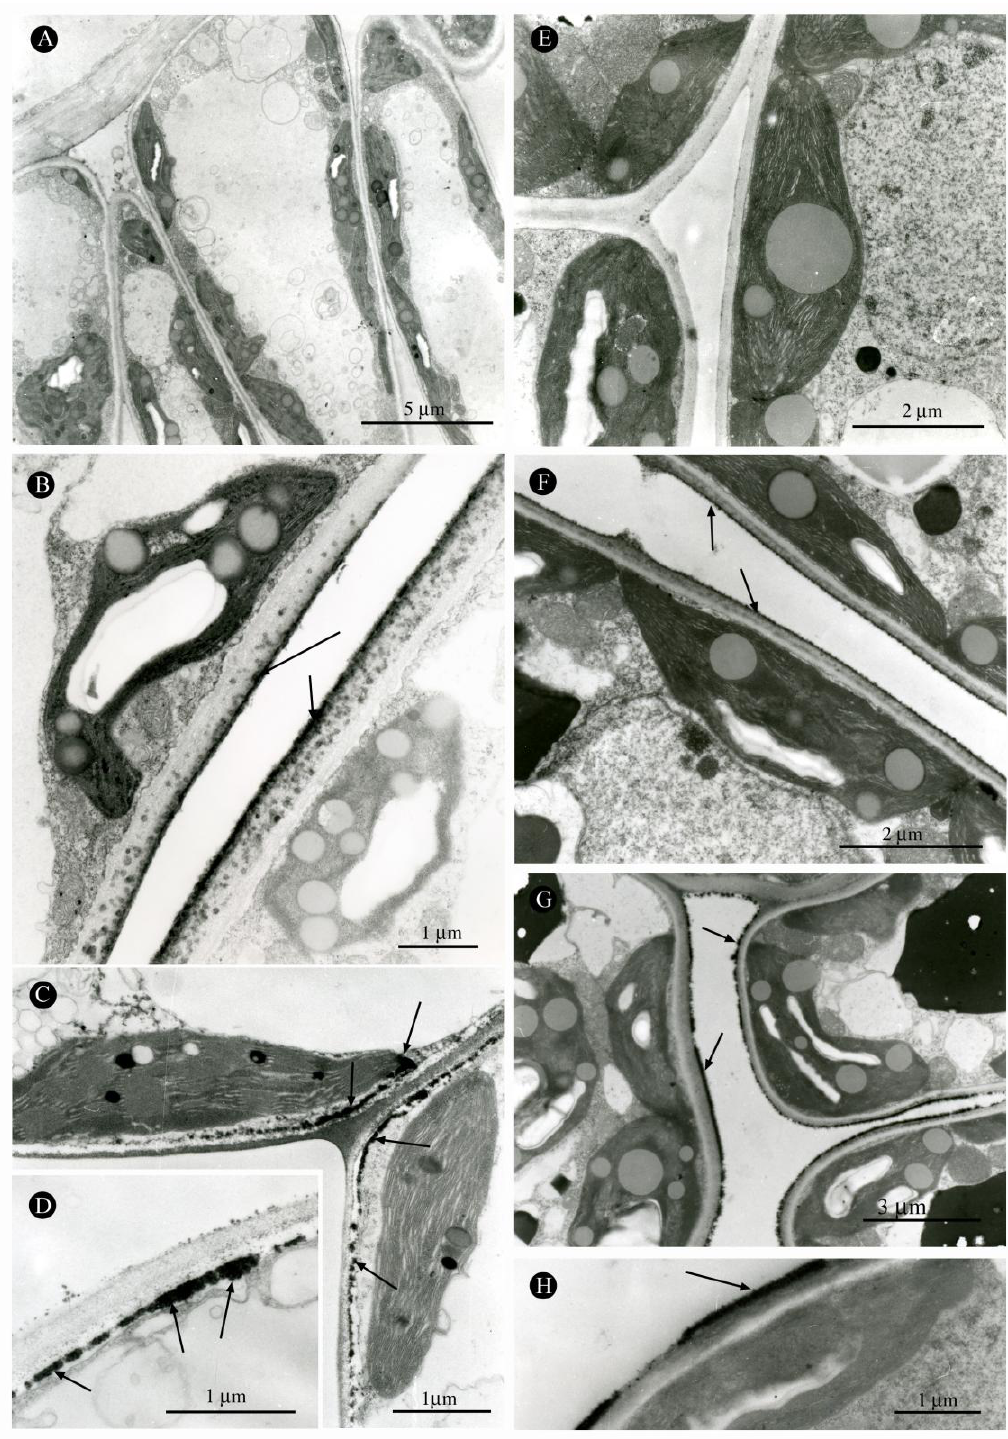
FIGURE 2. TEM of poplar (A–D) and beech (E–H) leaves, stained with CeCl 3 to evidence the presence and localization of H 2 O 2 . (A, E) CF chambers (control), (B–D, F–H) NF and OA chambers. (B, F–H) Samples collected May 30 (before the onset of visible symptoms). (C, D) Samples collected July 27. The dark deposits on the cell walls (arrows) indicate the presence of CeCl 3 oxidized with H 2 O 2